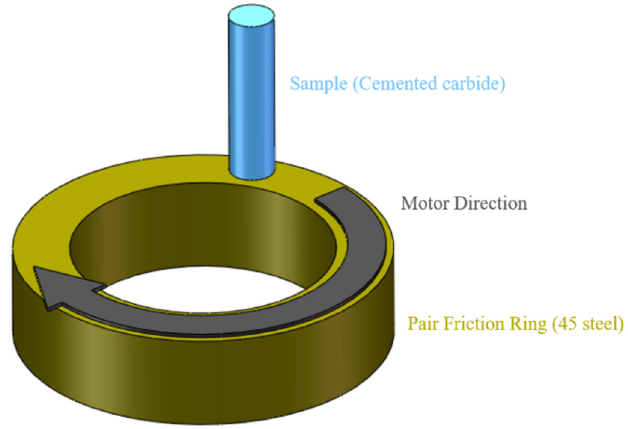
Figure 2. The pin-disc friction model.